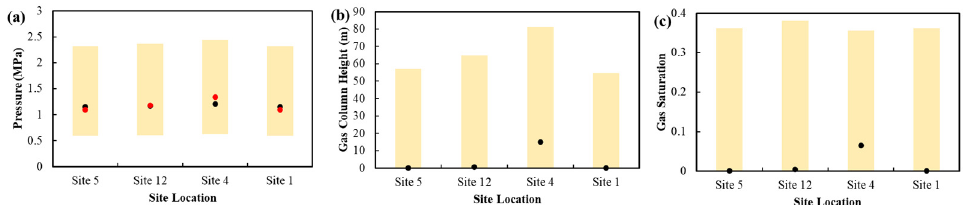
Figure 6. The median prediction of different parameters for the 4 sites. The black dots are the median prediction, and the shaded regions are the uncertainty ( ± 1 SD). ( a ) The capillary entry pressure ( P e ) of the sediments at BSR depth is shown here. The red dots are the fracture criterion at the respective sites. ( b ) The gas column height of the FGZ required to open fractures at the BSR depths is shown here. ( c ) The minimum gas saturation of the FGZ required to open the fractures at the BSR depths is shown here.